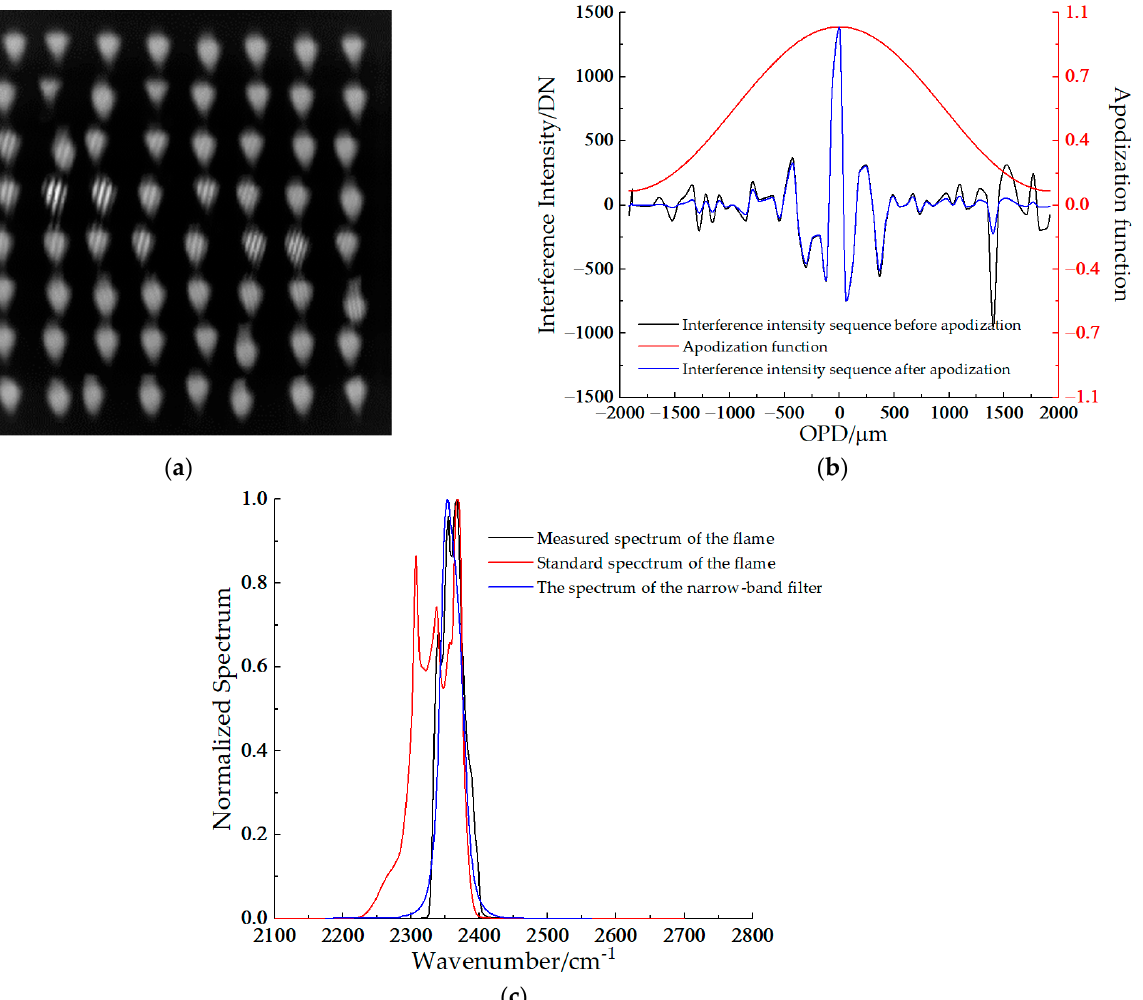
Figure 16. The detection results of the flame from the alcohol burner measured by SIIFTS: ( a ) the interference image array of the flame; ( b ) the interference intensity sequence of the central pixel is obtained after image segmentation and image registration; ( c ) the reconstructed spectrum is obtained according to the interference intensity sequence.